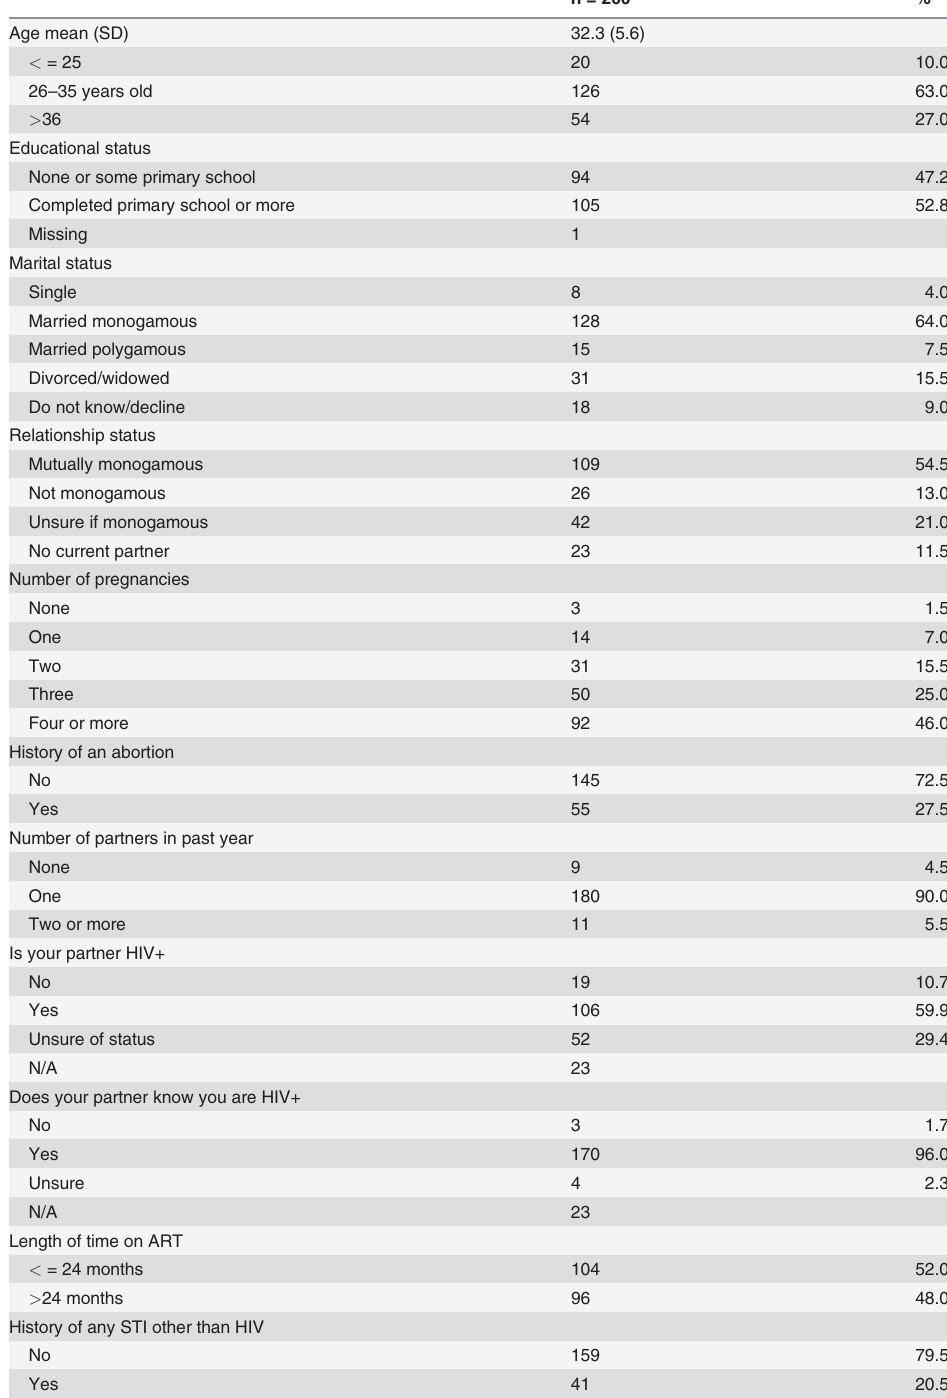
Table 1. Characteristics of 200 women enrolled in